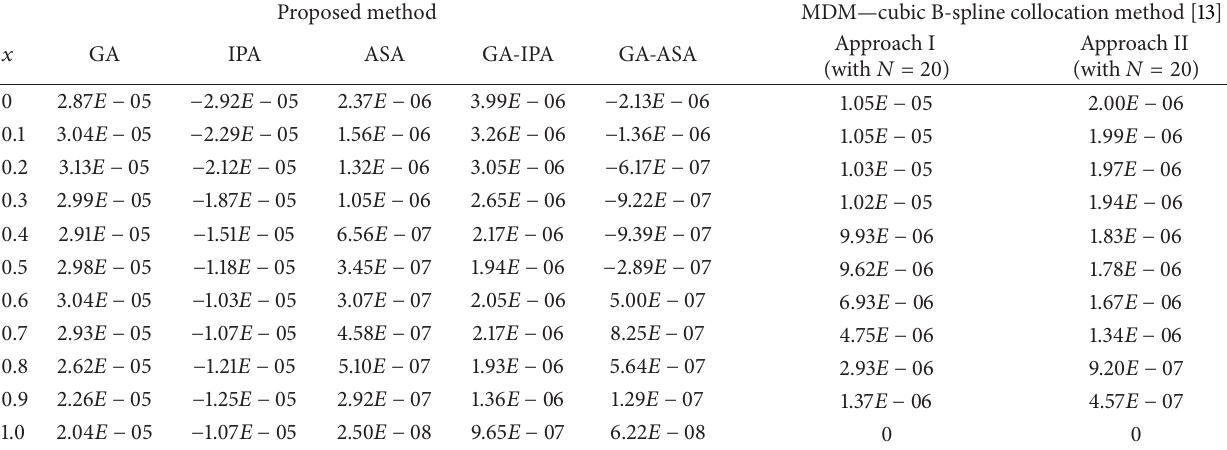
Table 4: Comparison of absolute errors for Example 1 between proposed method and the method given in